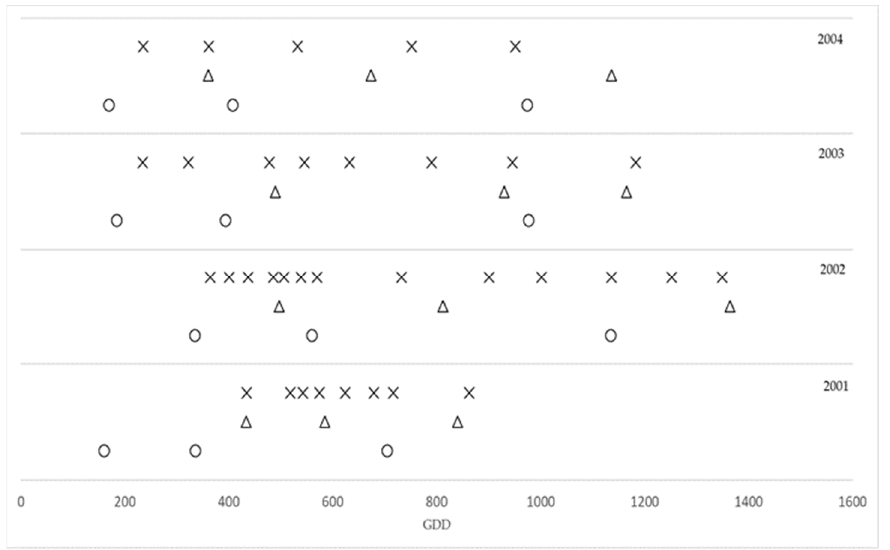
Figure 2. Accumulated growing-degree-days for N application (circle), plant sampling (triangle), and reflectance measurements (cross) for 2001, 2002, 2003, and 2004. The starting date for GDD was set on 1st January in the seed harvesting year, and T base was set at 2 °C.